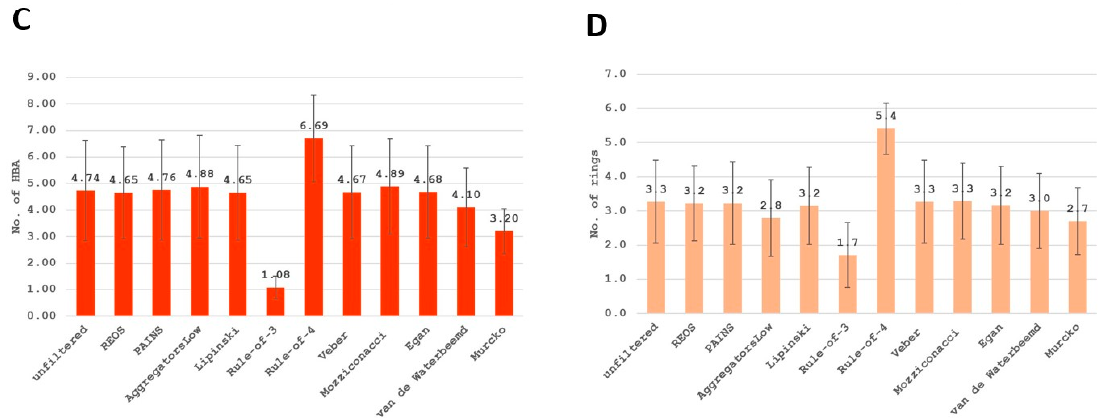
Figure 3. ( A ) The average descriptor value with SD of the No. of rotatable bonds for the unfiltered and filtered libraries. The graph bears resemblance to the other graphs where Ro3 and Ro4 stand out, with the other filters having average values close to the unfiltered library. ( B ) The average descriptor value with SD of the No. of HBD. We see that molecules that pass the aggregators filter have a slightly higher value of hydrogen bond donors. What is interesting is also the fact that the Ro4 scores lower than the average, despite having molecules that are larger and contain more N and O atoms which are usually involved in hydrogen bonding (Figure 4). ( C ) The average descriptor value with SD of the No. of HBA before and after filtering of the library. The Ro3 filter has a significantly lower value as its aim is to find the starting fragments from which the molecule is built. This usually leaves space for the attachment of desired functional groups to the fragment, but as a result the number of HBA is lower. ( D ) The average descriptor value with SD of the No. of rings present before and after filtering of the library. As Ro4 shifts the chemical space towards larger molecules the number of rings increases as well. The opposite happens with Ro3 where the small molecular weight does not allow for a large number of rings to be present.